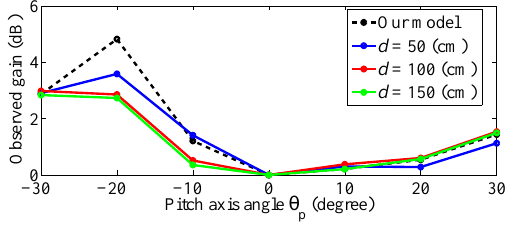
Figure 17. Observed power ratio in 2500–4000 Hz